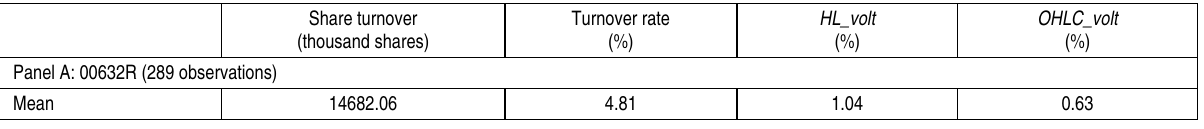
Table 1. Summary statistics for the trading-activity variables of the three inverse ETFs